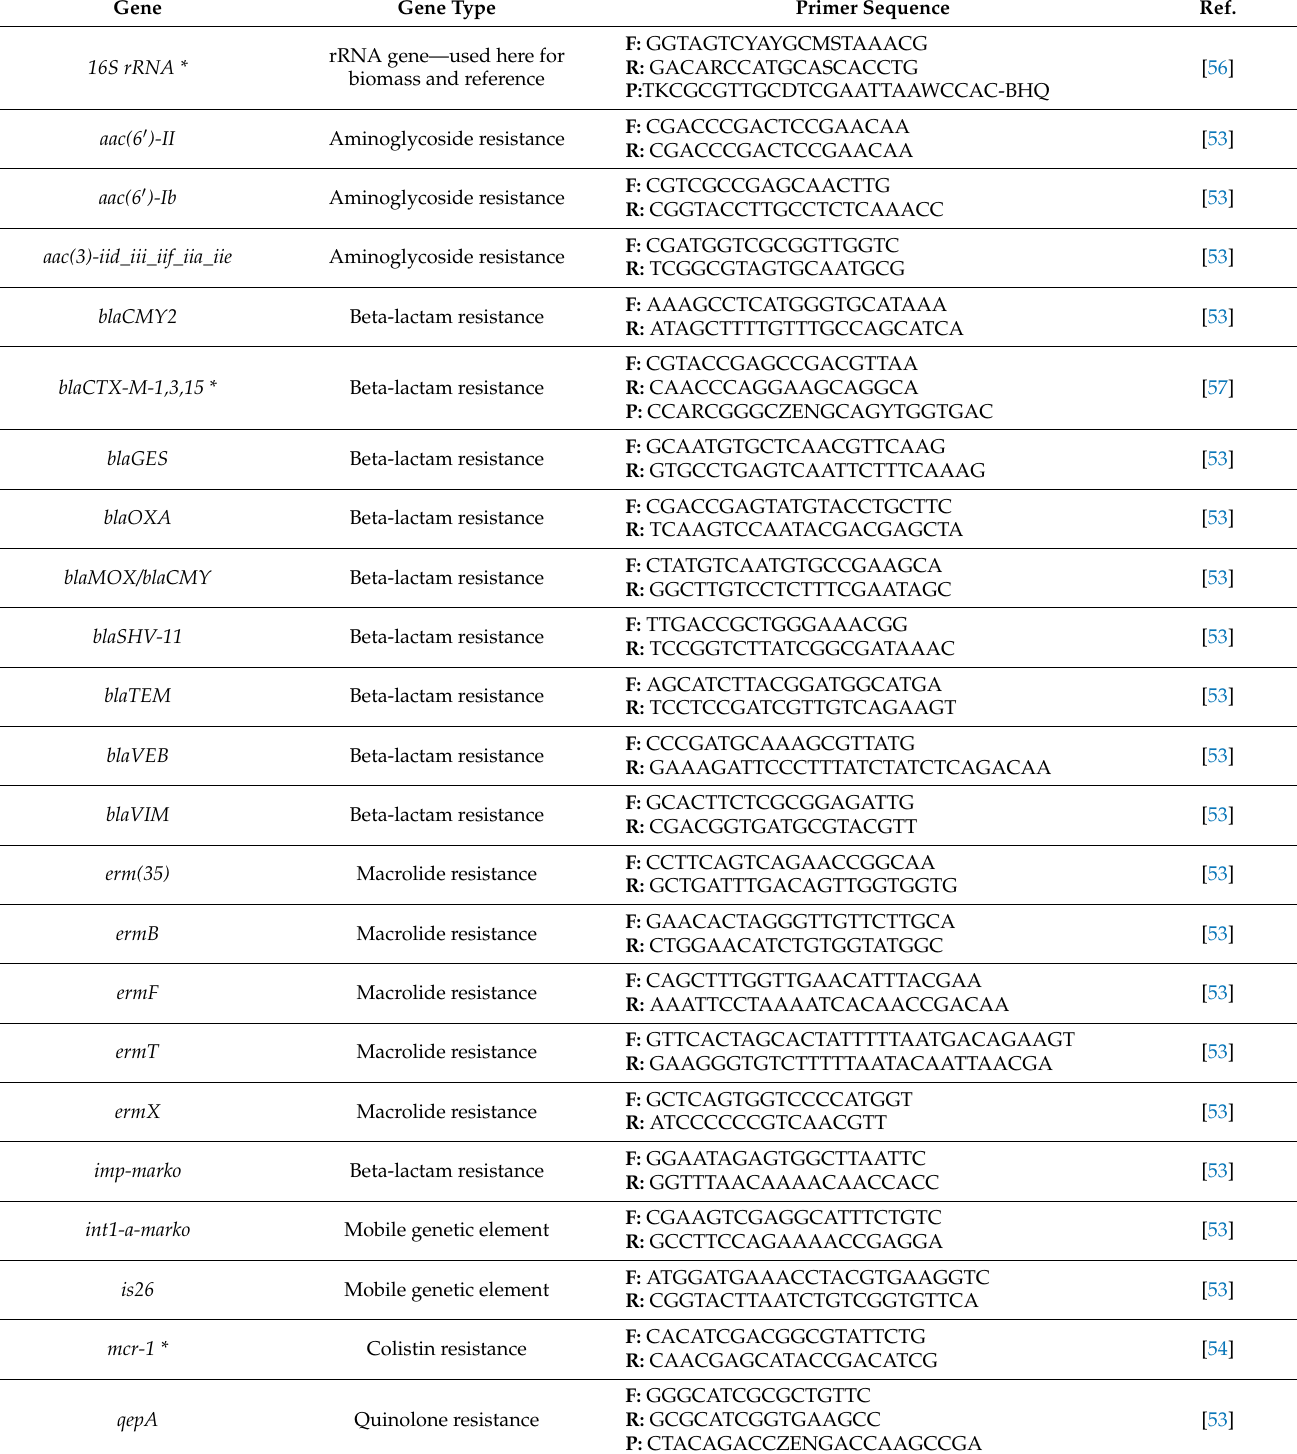
Table 3. List of shared gene targets and primers used for qPCR analyses. Genes noted by * used a FAM probe all others used SYBR Green